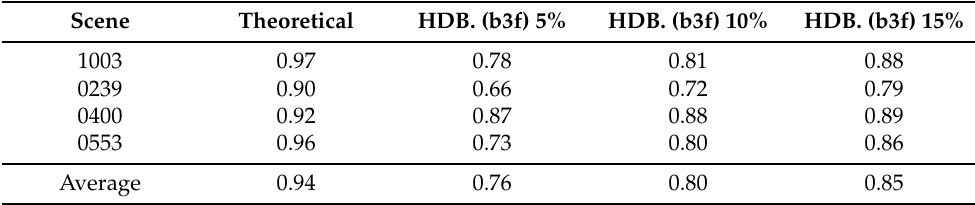
Figure 4. Semi-supervised clustering for a pre-labeled sample in Scene 0239. Table 3. Average ARI results for HDBSCAN(b3f) based on different percentages of pre-labeled instances, with a minimum of two pre-labels. Unsupervised stability was used to decide ties. “Theoretical” refers to the case of 100 percent pre-labels as in Table 2. For all experiments, Euclidean distance in x - y - v dimension was